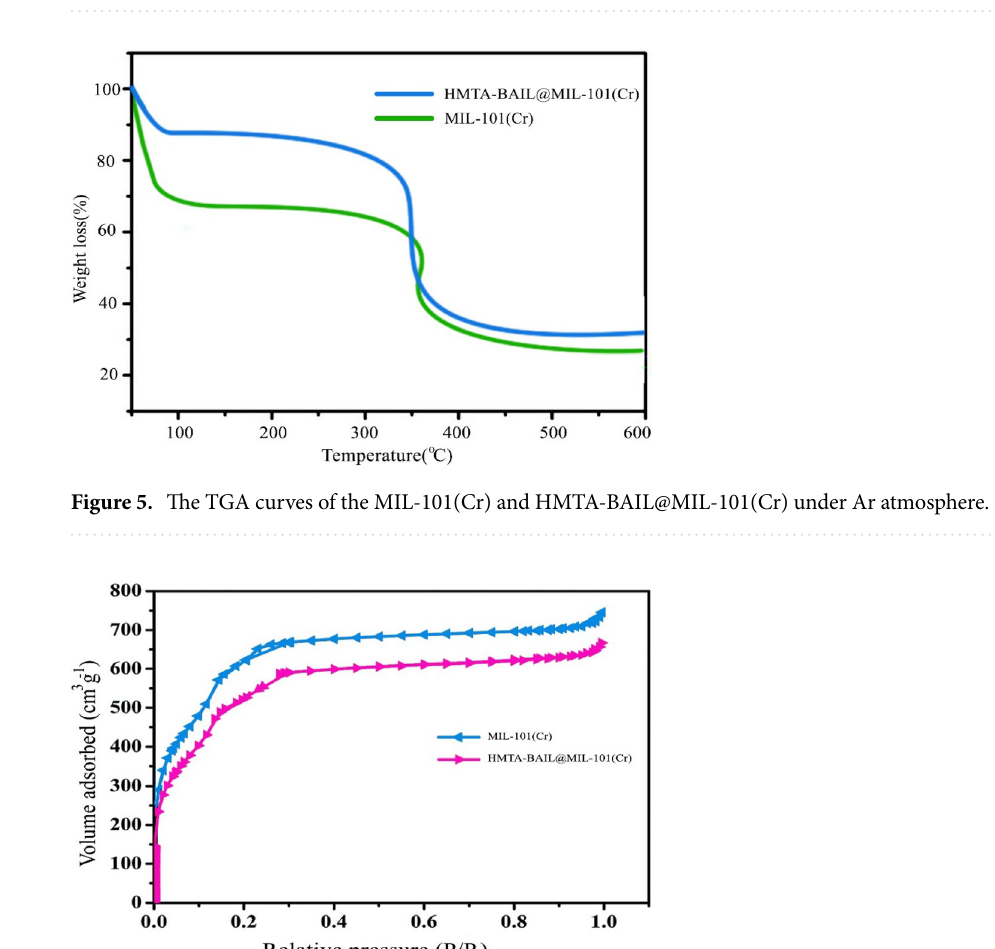
Figure 4. The FT-IR spectra of MIL-101(Cr) MOF and HMTA-BAIL@ MIL-101(Cr).